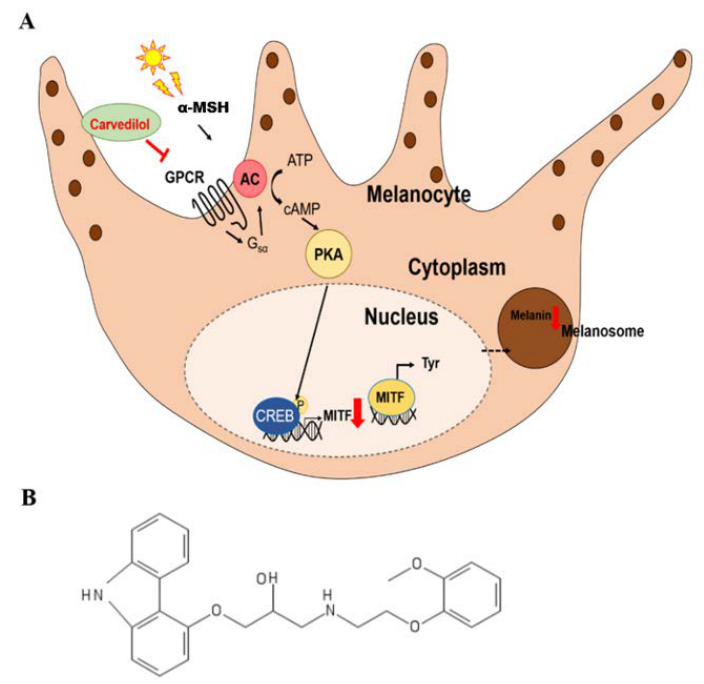
Figure 4. Summary of the mechanistic pathway by which carvedilol affects melanogenesis. ( A ) Summary of the mechanistic pathway underlying the effect of carvedilol on melanogenesis. ( B ) Chemical structure of carvedilol (1-(9 H -carbazol-4-yloxy)-3-[2-(2-methoxyphenoxy) ethylamino] propan-2-ol).